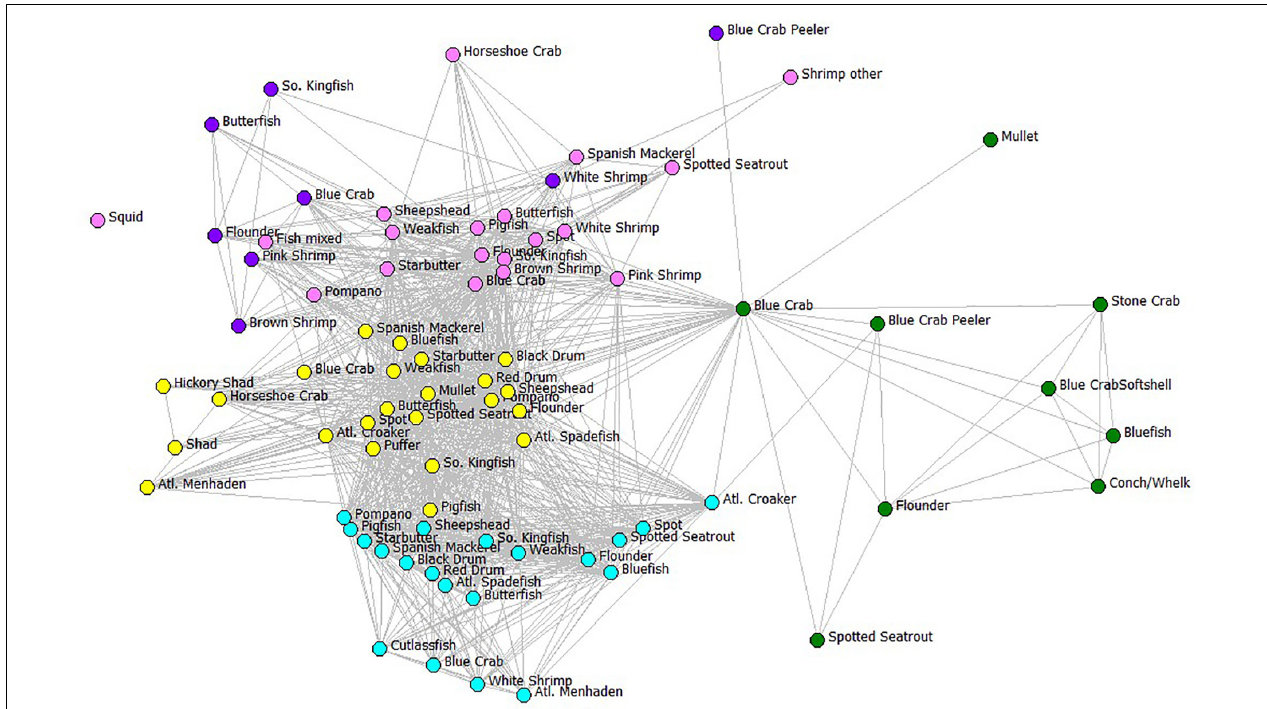
FIGURE 8 | The fisher behavioral network showing the results of a Key Player node removal based on distance-weighted maximum fragmentation criterion. Color codes represent the six gear types used in the ECOPATH model using the same color assignments as in Figure 7 and the species names or ECOPATH compartments as given in Table 1 . Edges between gear-species fisheries nodes indicate that at least one fisher was jointly involved in the two fisheries. The fishery nodes with greatest joint fisher participation were displayed using Fruchterman-Reingold spring-embedder algorithm (Fruchterman and Reingold, 1991), which places high-degree centrality nodes in the center of the